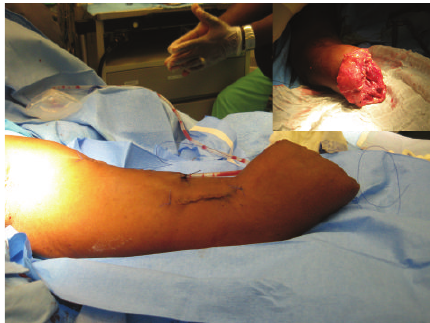
Figure 6: Viable tissue was only present at the proximal third of the forearm (inset). An amputation at the proximal third of the forearm was